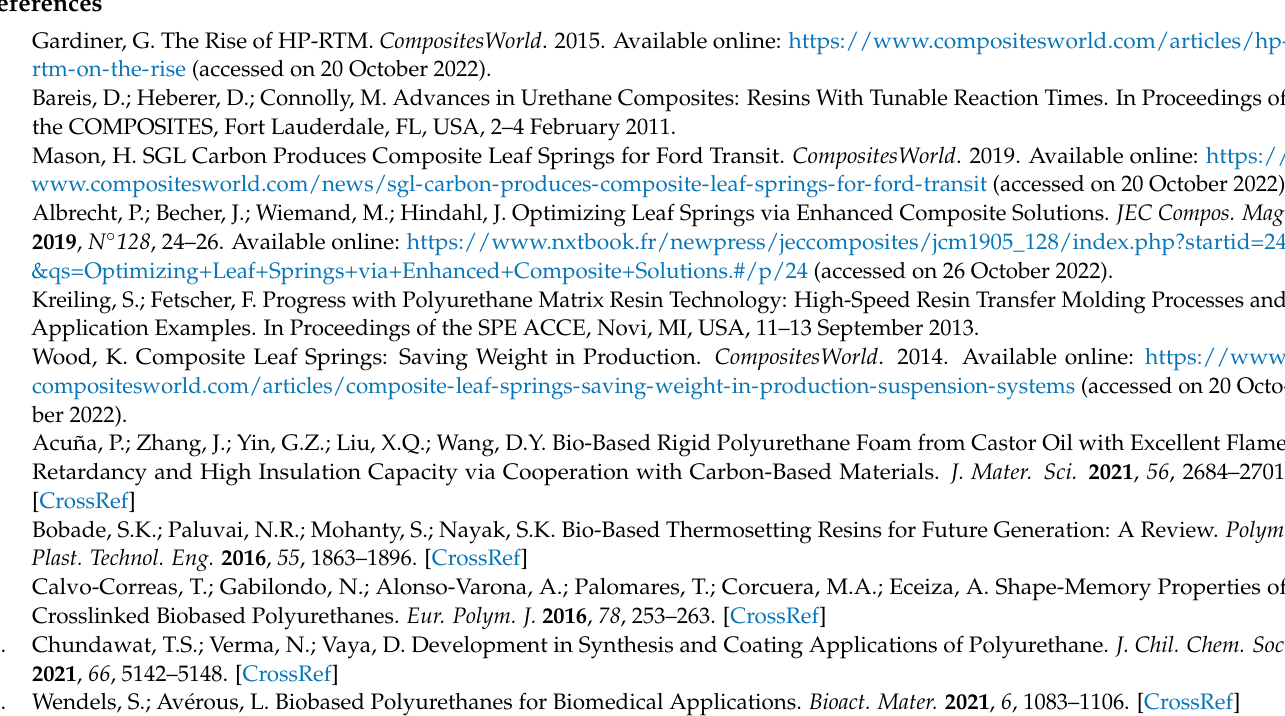
PUR systems, Table S2: Viscosity model parameters for BIO-PUR systems, Figure S1: Polyurethane resin system preparation, Figure S2: Flow front evolution for BIO-PUR3. Experimental (symbols) and simulation (?)